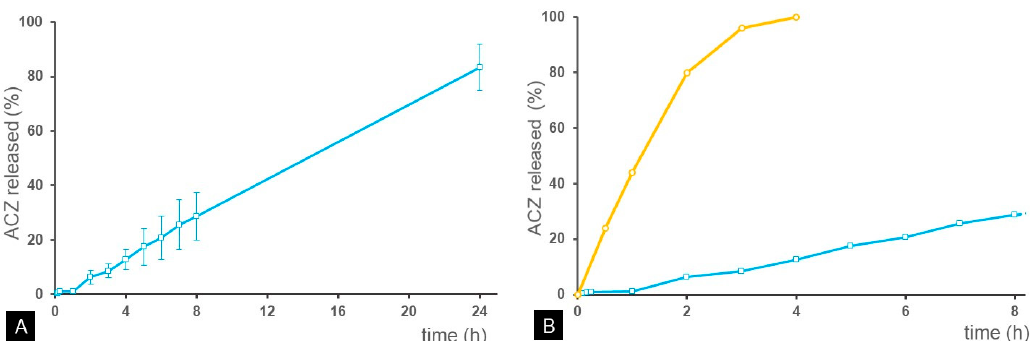
Figure 4. In vitro release profile of acetazolamide (ACZ): ( a ) ACZ-loaded nanoparticles dispersed in phosphate-buffered solution isotonized with NaCl (24h), ( b ) aqueous solution of ACZ (yellow) [39] versus ACZ-loaded nanoparticles (8h).